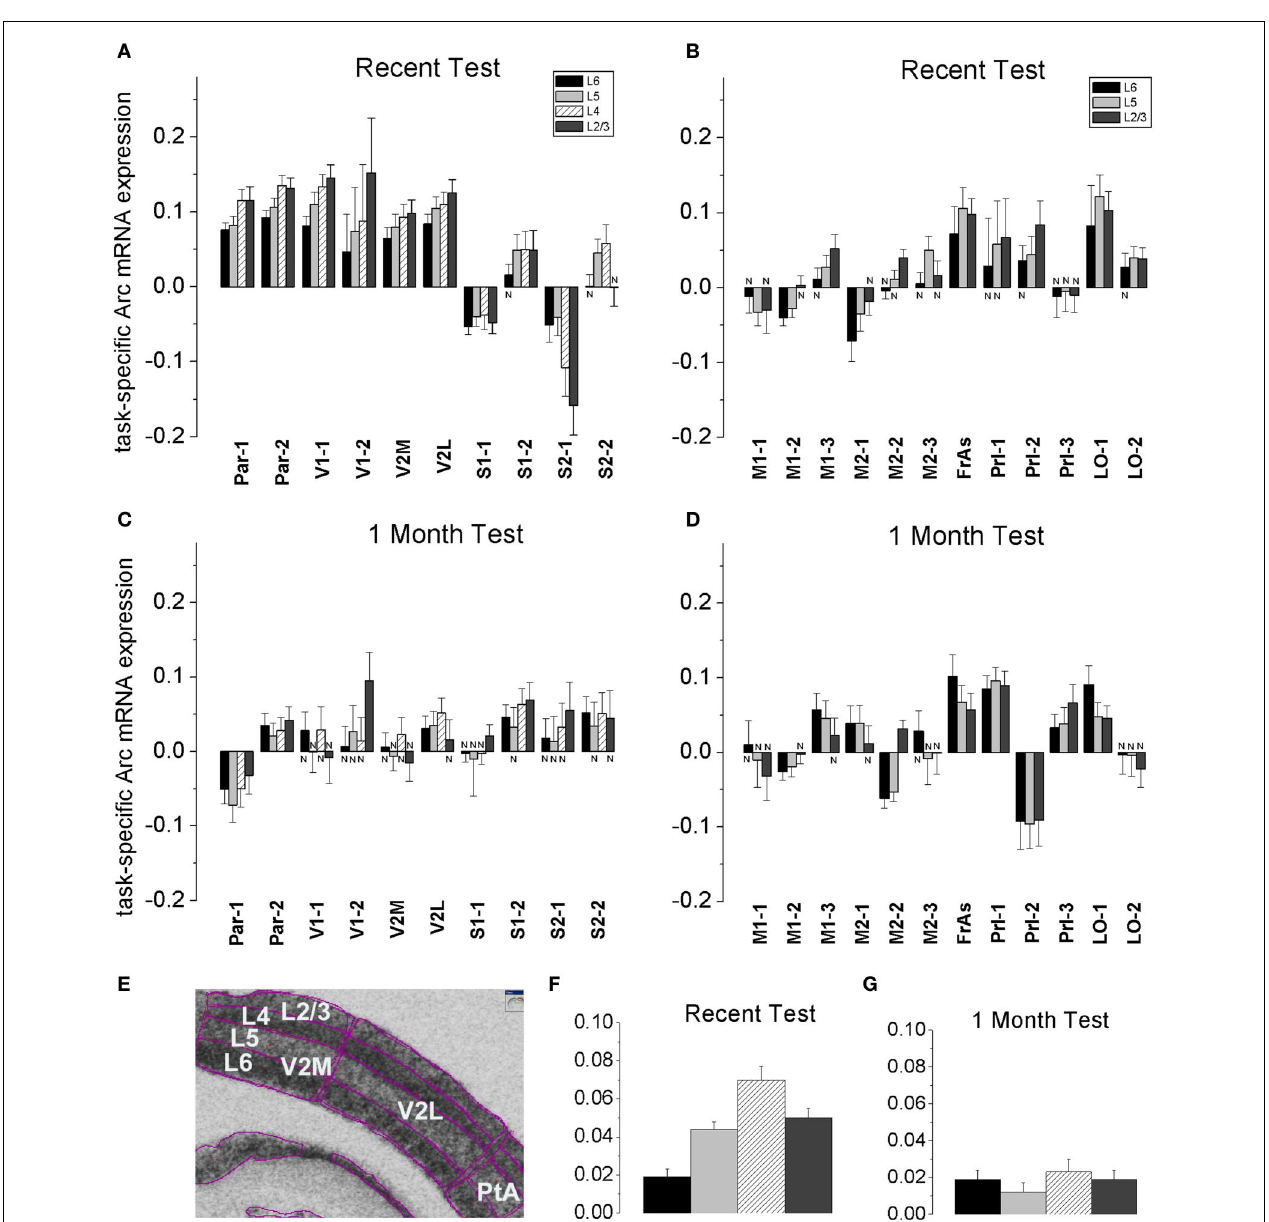
FIGURE 4 | A stereotypical laminar profi le of task-specifi c increase in Arc expression levels appeared after recall of recent but not remote memories. (A,B,F) A recent memory test was accompanied by a larger increase in Arc mRNA expression in L2/3 and L4, while the increase in Arc expression was less in L6 in Par, V1, V2M and V2L, S1-2 segments. The tendency for the smaller L6 increase in Arc signal was also preserved in 5-layered areas such as FrAs, Prl, LO, M1-3 and M2-2. Data represent group means ± SE of WMT and SW Arc mRNA differences, N-the WMT vs. SW difference is not signifi cant. (E) The layers’ boundaries were traced with confi dence. L2/3 and L4 boundaries were